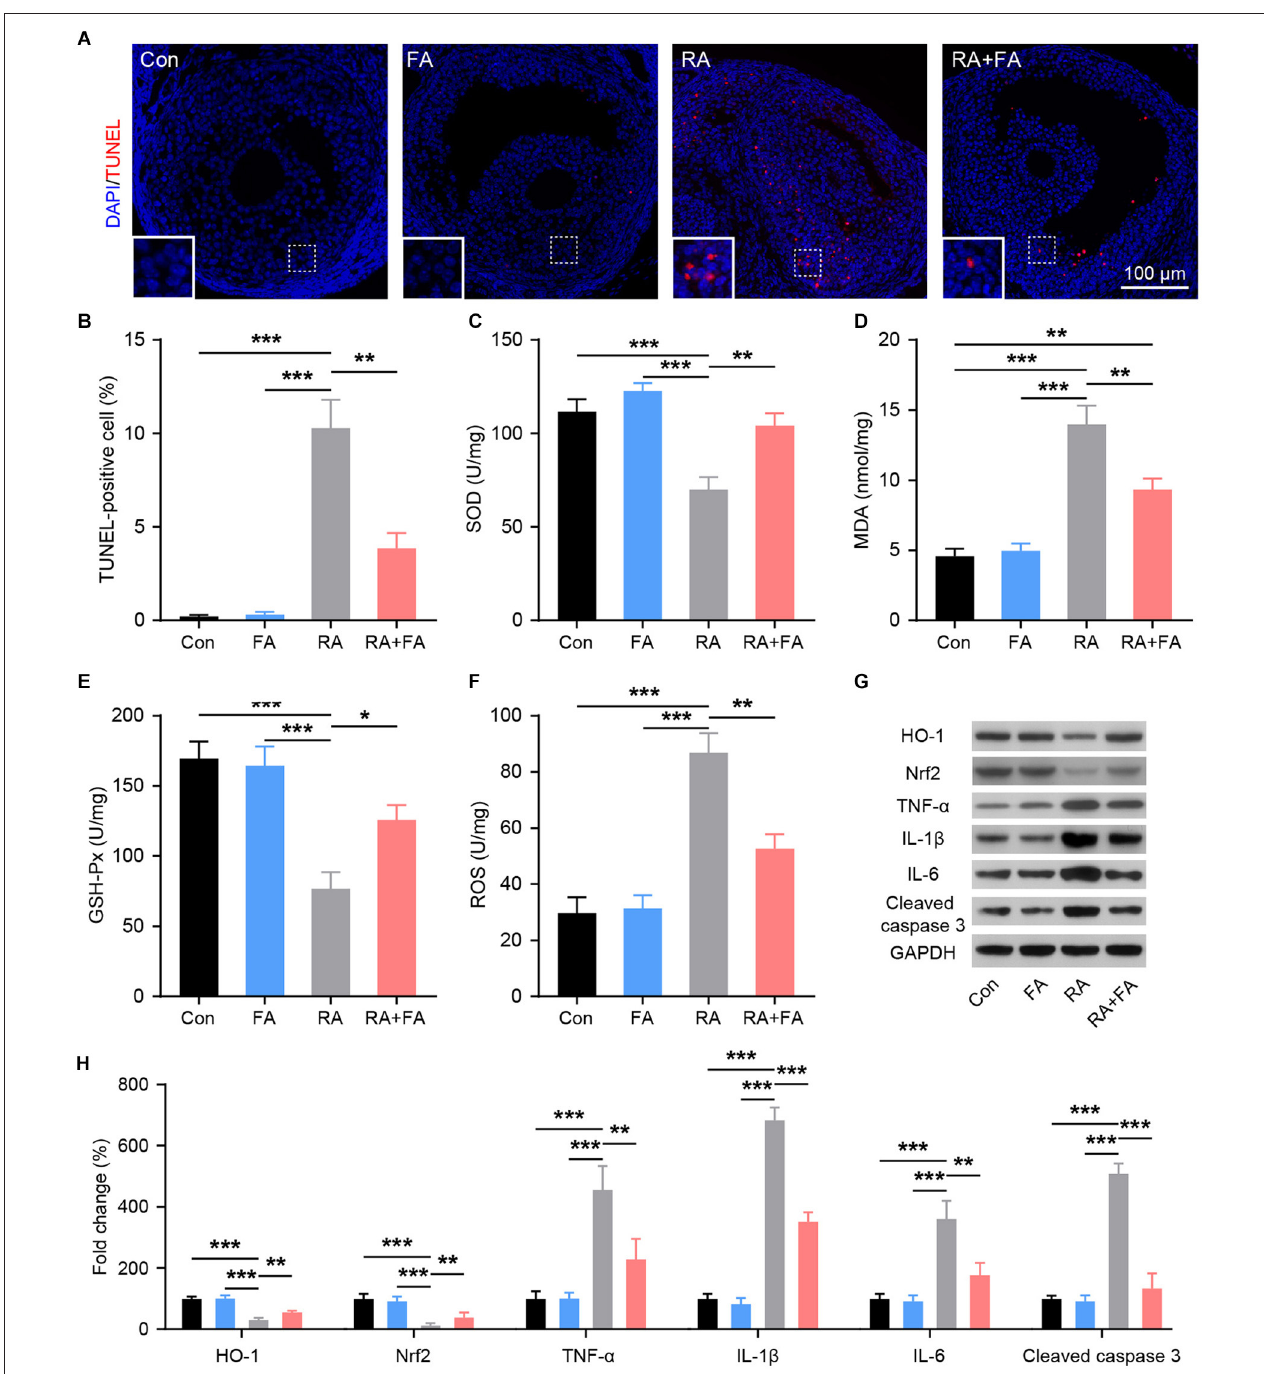
FIGURE 4 | Effect of folic acid (FA) pre-administration on radiation-induced ovarian apoptosis, oxidative stress, and inflammation. (A,B) Ovarian follicle cell apoptosis was determined via TUNEL staining. Apoptotic cells are stained in red, and nuclei are stained in blue (DAPI). Scale bar, 100 µ m. (C–F) Effect of FA pre-administration on the levels of SOD, MDA, GSH-Px, and ROS in ovarian homogenates. SOD, superoxide dismutase; MDA, malondialdehyde; GSH-Px, glutathione peroxidase; ROS, reactive oxygen species. Each ELISA assay was repeated three times. (G,H) Western blot was performed to detect the protein levels of HO-1, Nrf2, TNF- α , IL-1 β , IL-6, and Cleaved caspase-3 in ovarian tissues from each group.in ovarian tissues from each group. HO-1, heme oxygenase 1; Nrf2, nuclear factor-erythroid 2-related factor 2. TNF- α , tumor necrosis factor- α ; IL-1 β , interleukin-1 β ; IL-6, interleukin-6; Con, control group; FA, FA pre-administration control group; RA, radiation exposure group; RA + FA, FA pretreatment + radiation exposure group. Error bars, standard error of mean (SEM). N = 8, * p < 0.05, ** p < 0.01, and *** p < 0.001.